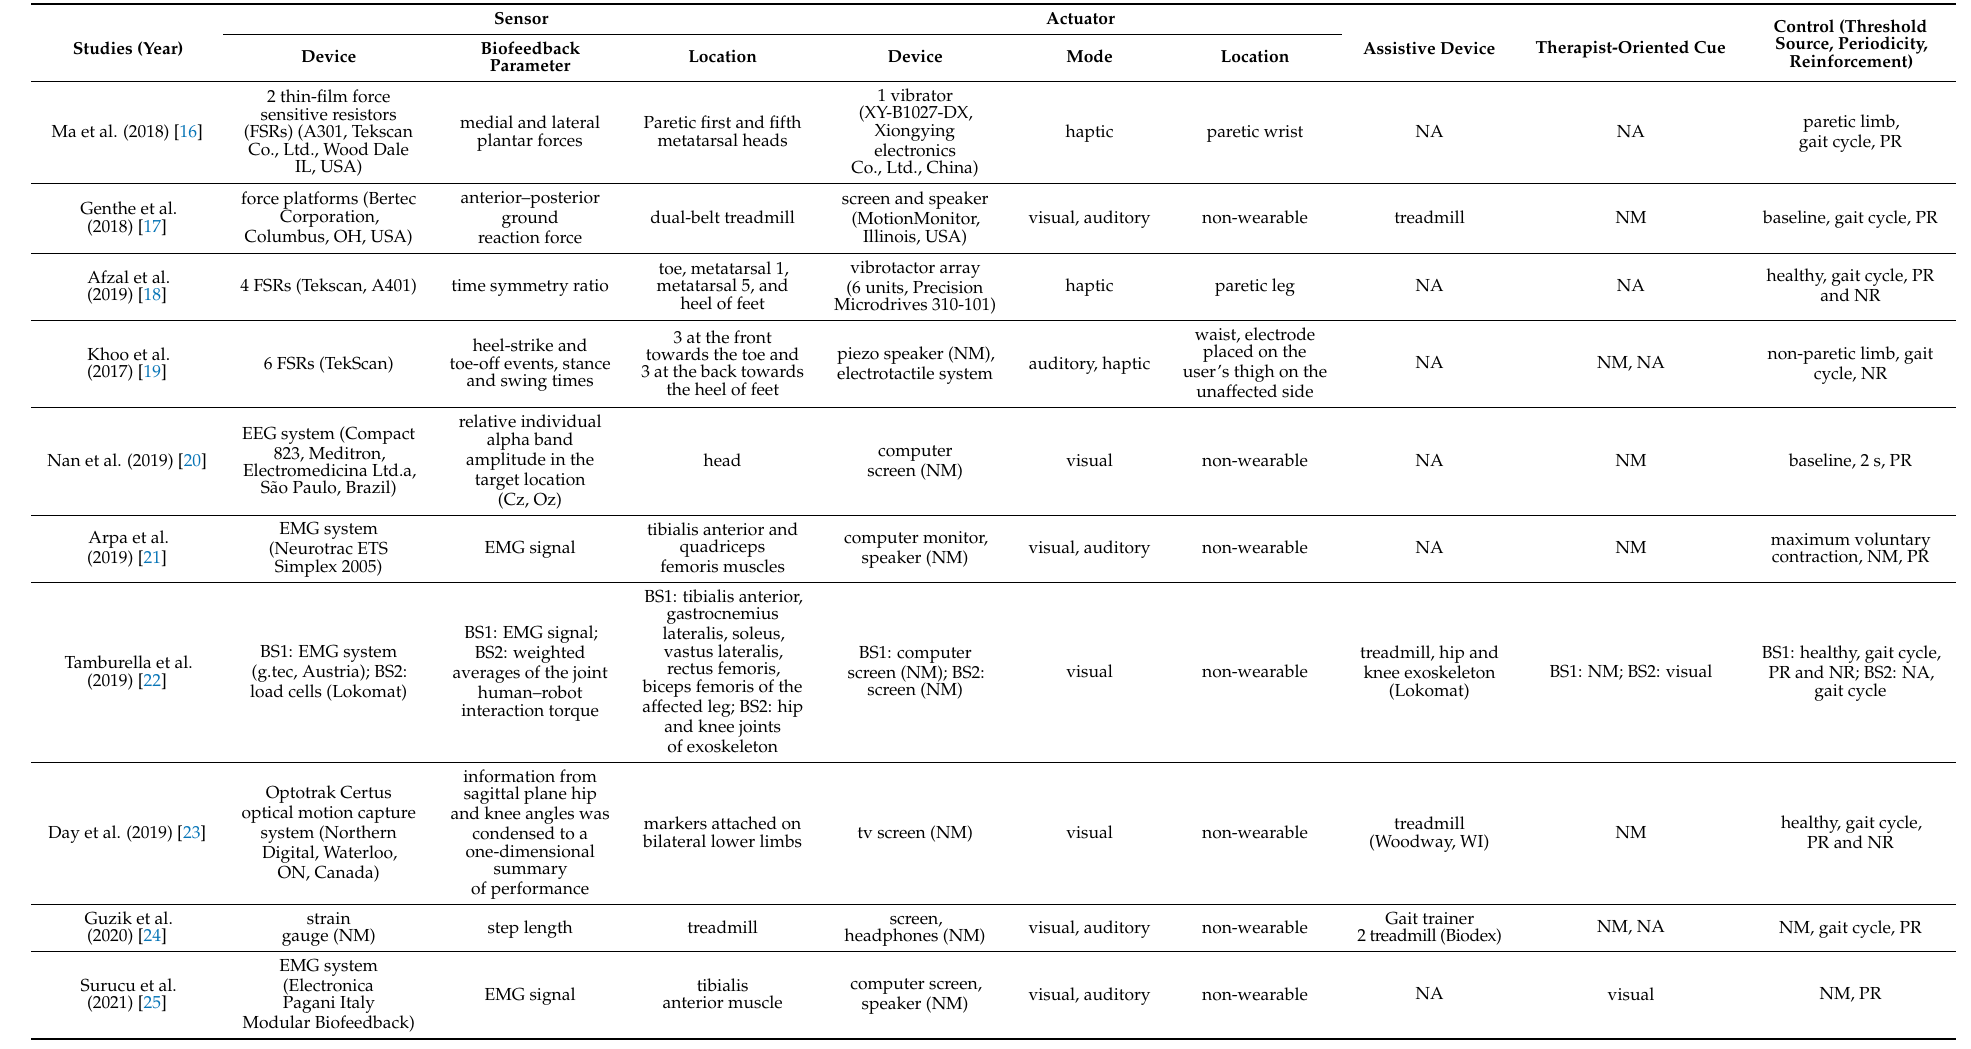
Table 1. Technical specifications (NA—Not Applied, NM—Not Mentioned, PR—Positive Reinforcement, NR—Negative